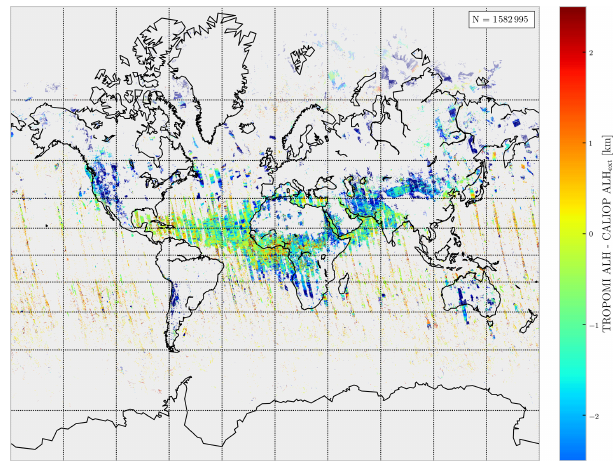
Figure 3. A map of cloud-filtered and sun-glint-filtered differences between co-located TROPOMI ALH and CALIOP ALH ext consid- ered for Fig.